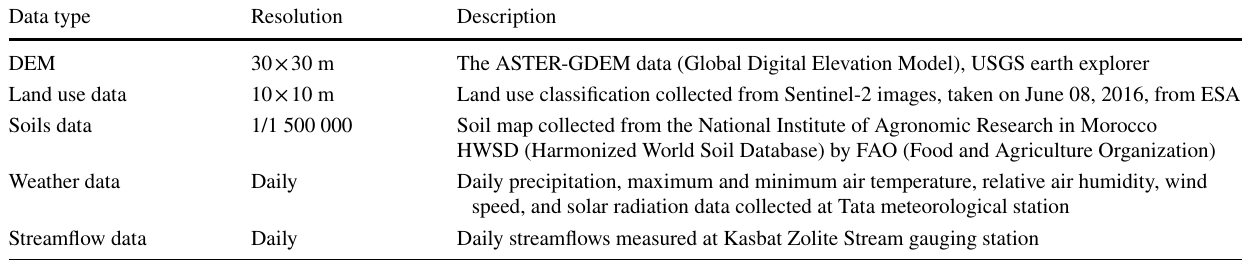
Table 1 Sources and descriptions of data used for the Tata River